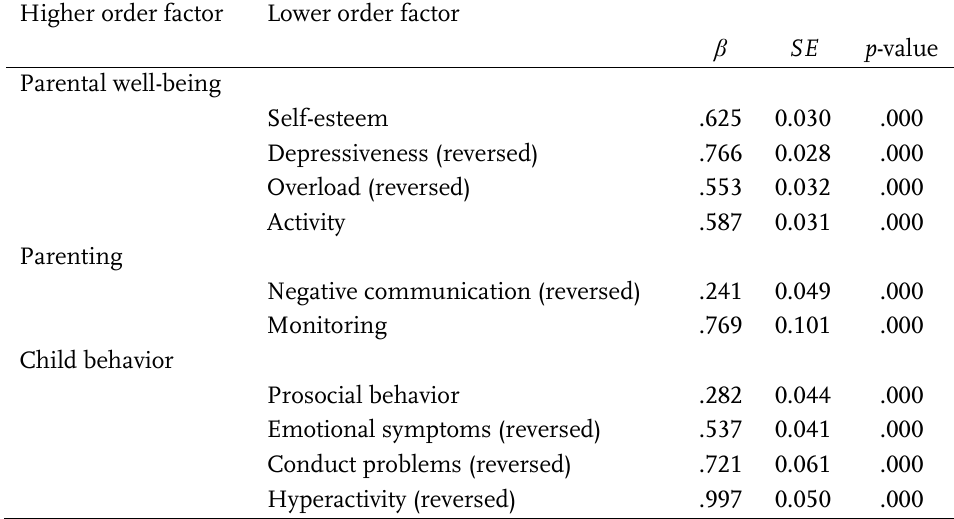
Table 1 : Measurement model – Higher order